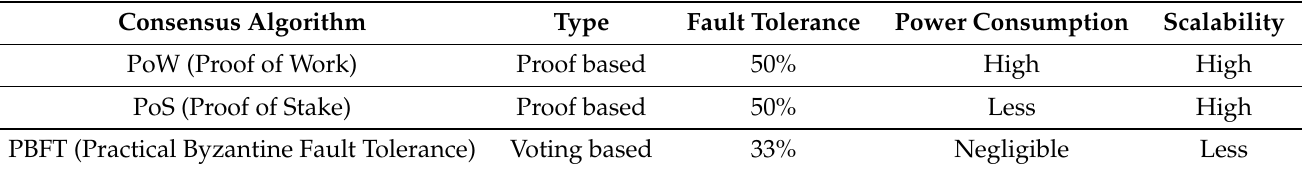
Table 1. Comparison PBFT with various PoW and PoS consensus